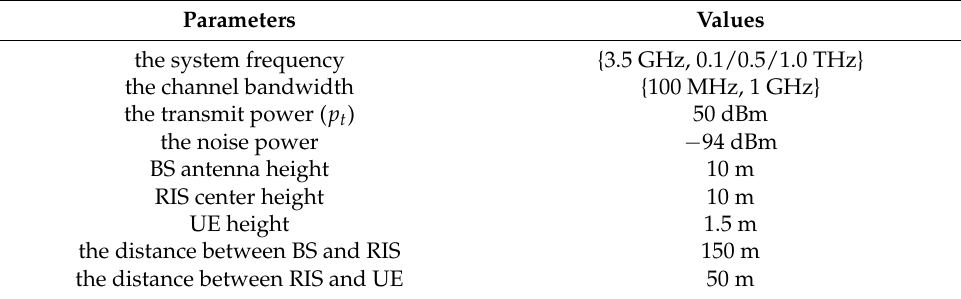
Table 2. Simulation Parameter